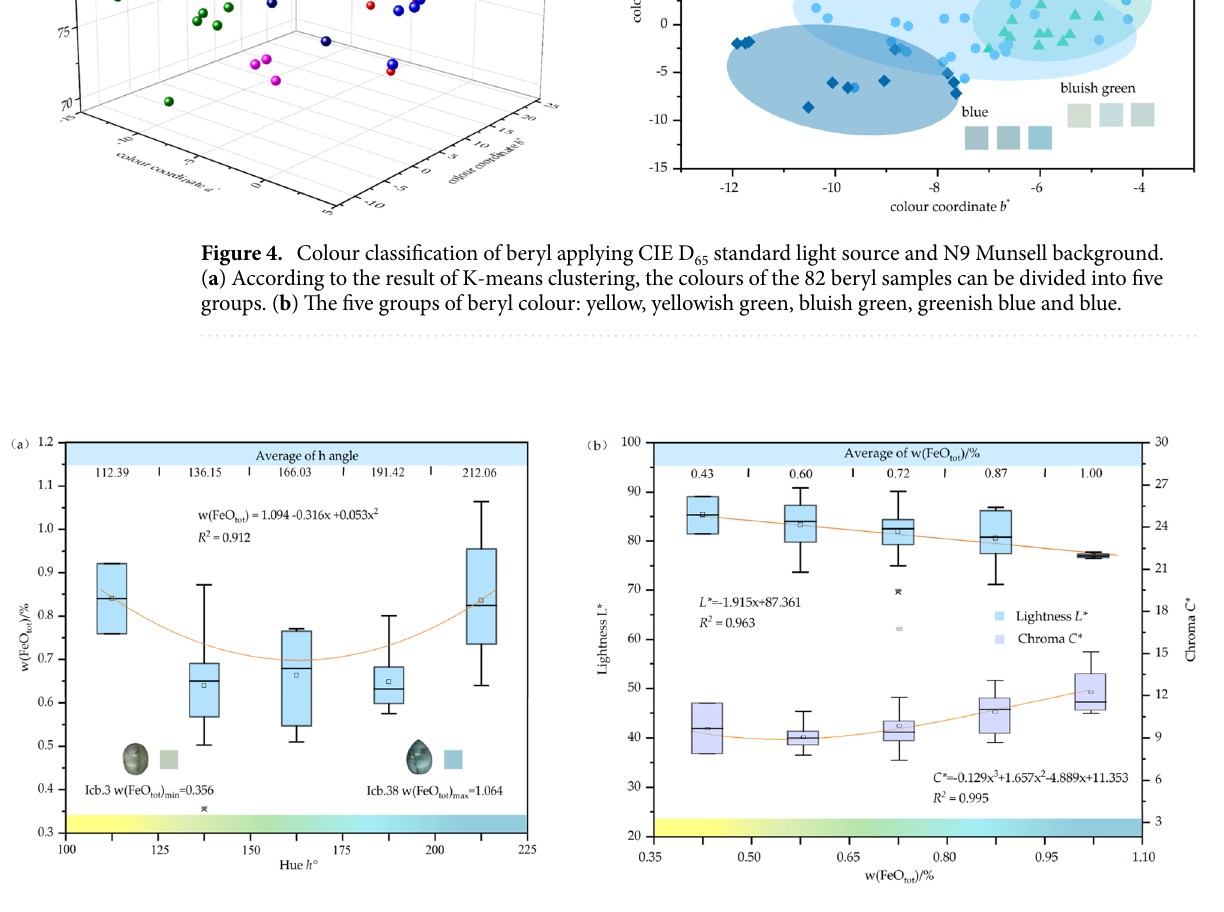
Figure 5. Relationship between iron and colour in beryl. ( a ) The iron content of beryl has a quadratic function with hue angle, and yellow and blue beryl have the highest iron content. ( b ) The iron content of beryl is inversely proportional to lightness and almost directly proportional to